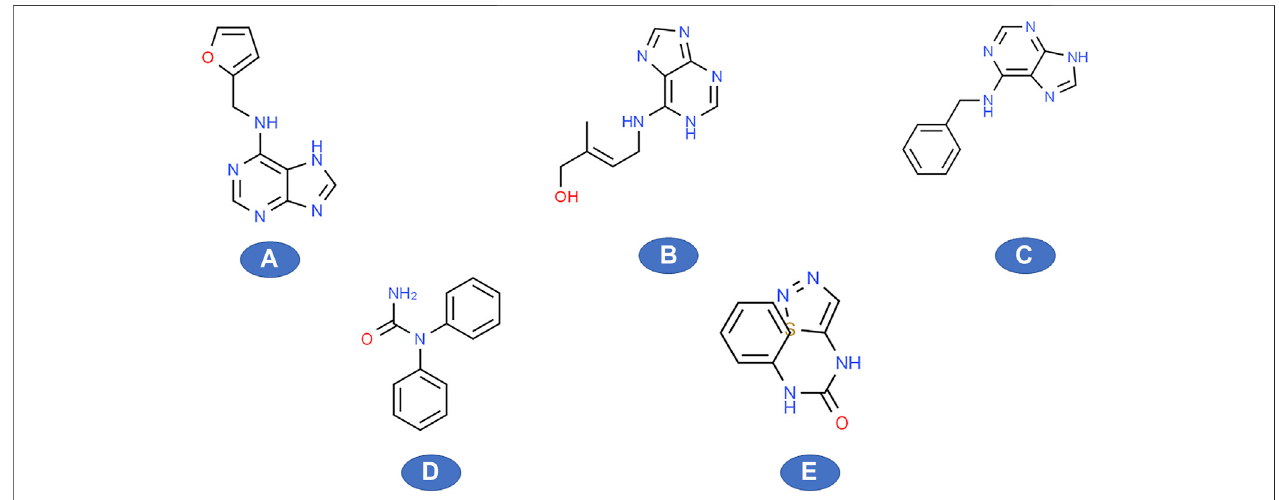
FIGURE 1 | Various natural and synthetic cytokinins (structures obtained from www.ChemSpider.com) (A) kinetin, (B) zeatin, (C) 6-benzylaminopurine, (D) Diphenylurea, (E) thidiazuron (TDZ).